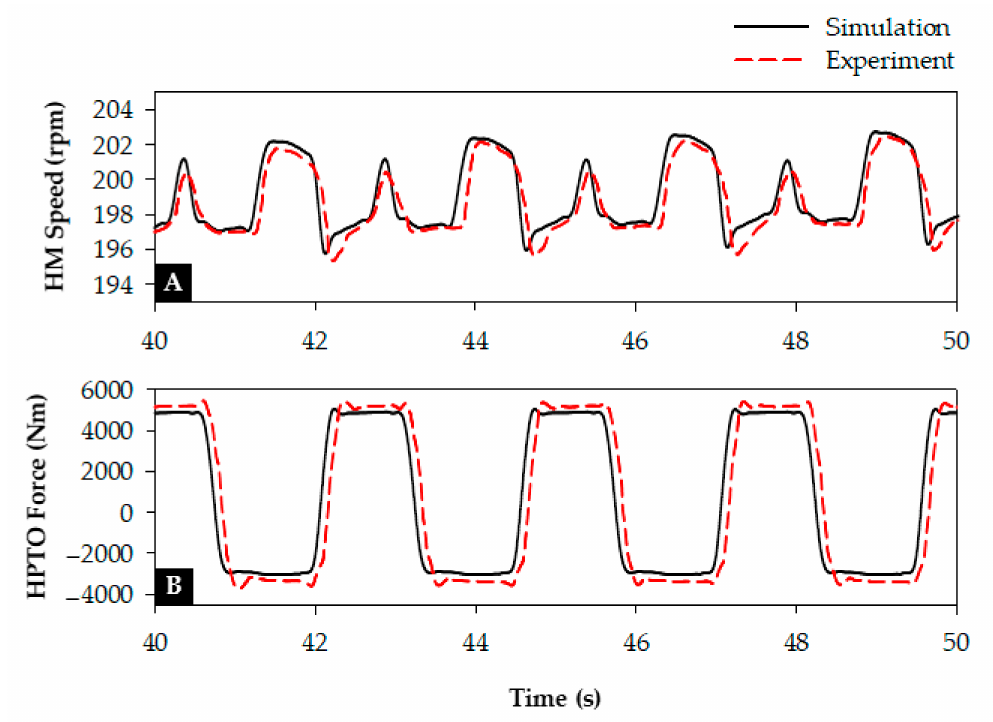
Figure 5. Behaviour of HPTO unit in a regular wave condition. ( A ) Speed of hydraulic motor and ( B ) HPTO force applied to the floater’s